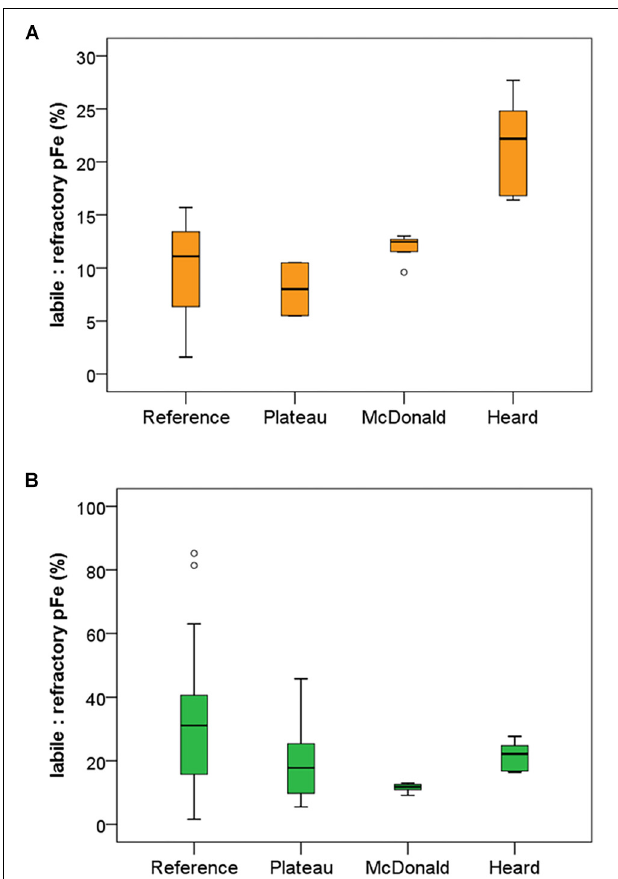
FIGURE 3 | Mean labile fraction of pFe (ratio of labile to refractory pFe) at each of the contrasting regions within the study. Labile fraction of pFe is shown within the mixed layer only (A) and within the full water column (B) . Standard boxplot median (centre black line), 25th and 75th percentiles (upper and lower box limits) and 95% confidence intervals (inner fences) are indicated. Outliers are shown as open circles and defined as less than 1.5 times the interquartile range. The number of independent data points for the reference, plateau, McDonald and Heard regions were 3, 2, 8, and 9 for panel a and 15, 13, 12, and 9 for panel (A) , respectively. Variability is generally lower near Heard and McDonald Islands due to the water column being well mixed in comparison to the reference and plateau stations.